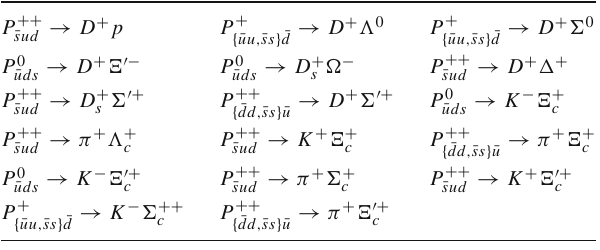
Table 8 The golden channels of decays with Cabibbo allowed P ( cc ¯ qqq